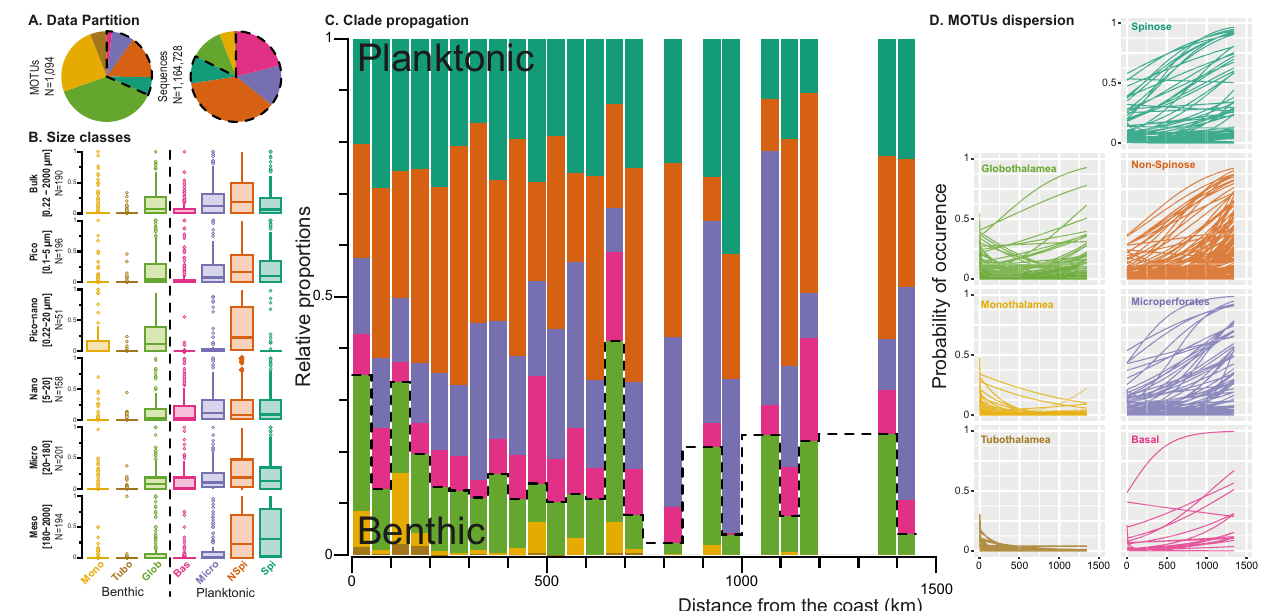
Fig. 2 | Dispersion of benthic foraminifera in the plankton. A Relative con- tribution of benthic and planktonic clades to MOTUs and sequences in the TARA Oceandataset. B Sequenceproportionsofthemainforaminiferacladesacrosssize fractionsoftheTARAOceandataset(Boxplotsdisplaytheinterquartilerange(box), extrema (whiskers), and outliers (dots)). C Average sequence proportions of